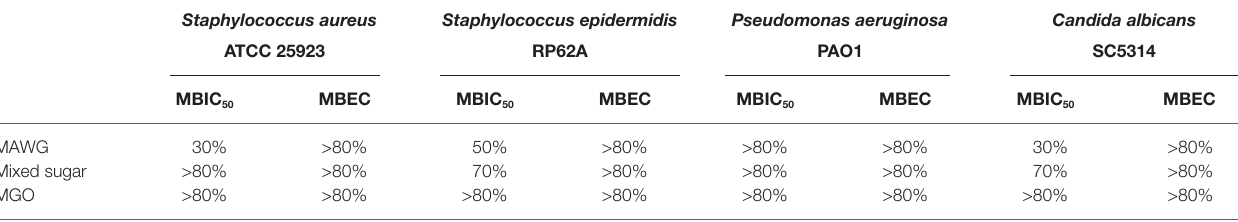
TABLE 2 | Susceptibility of microplate-based biofilms to MAWG and its active